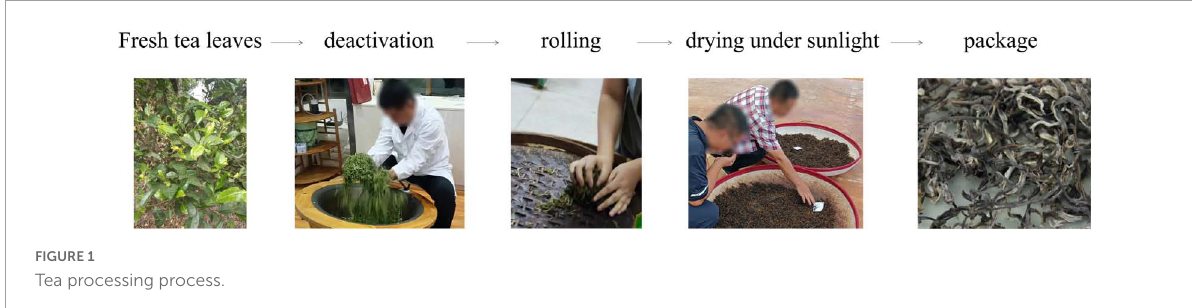
FIGURE1 Tea processing process.